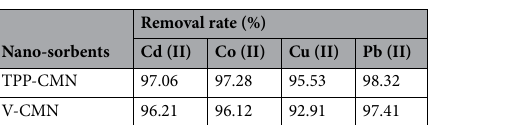
Table 4. Applicability of nano-sorbents to remove metal ions from mixed metals in a